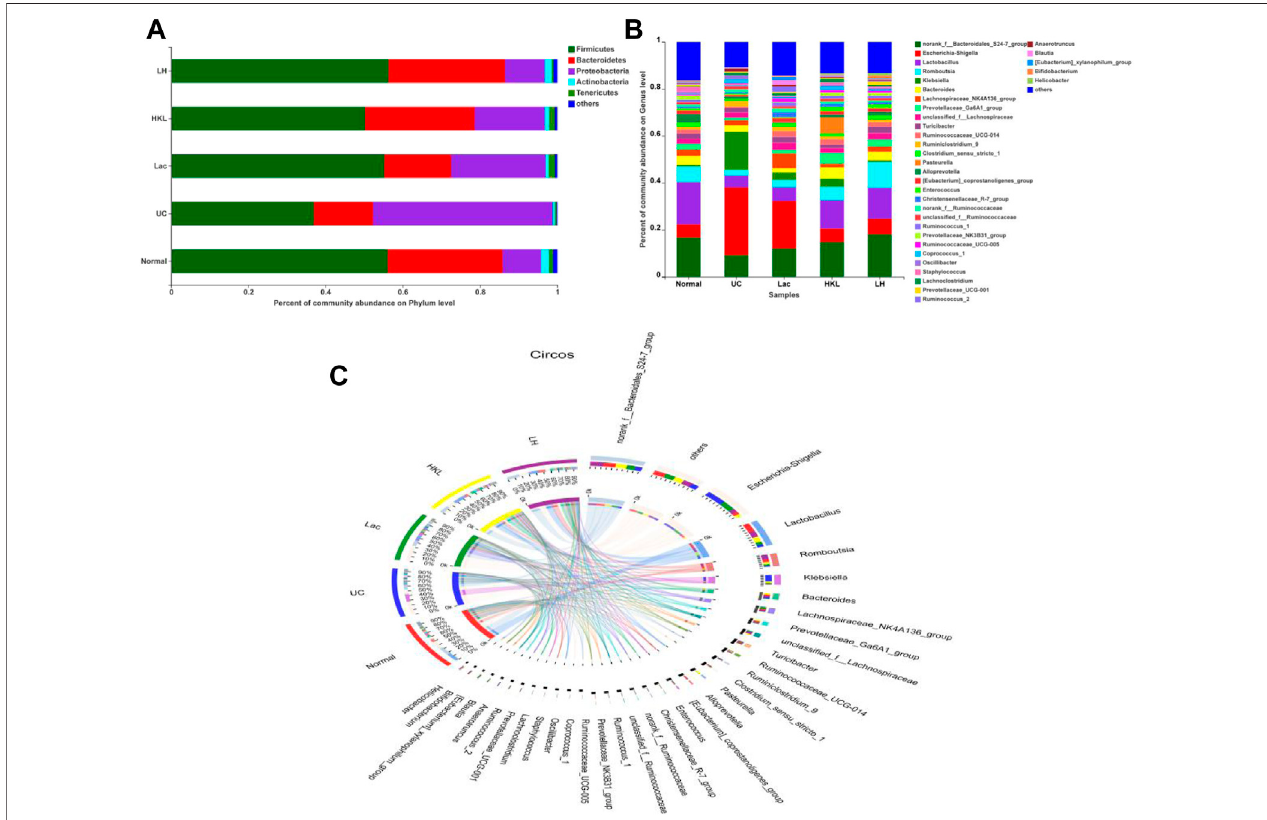
FIGURE 4 | Gut microbiota composition analysis ( n = 5~6). (A) Bar plot of bacterial richness distribution at the phylum level; (B) bar plot of bacterial richness distribution at the genus level; (C) diagram of Circos analysis. Indicated are the species composition (small left semicircle), the group (color of the outer ribbon), the species (color of the inner ribbon), and the relative abundance of the species in the corresponding samples (length). The large right semicircle represents the distribution of species in samples at the taxonomic level. The outer layer ribbon represents the species, the inner ribbon color represents different groups, and the length represents the distribution proportion of the sample in a speci fi c